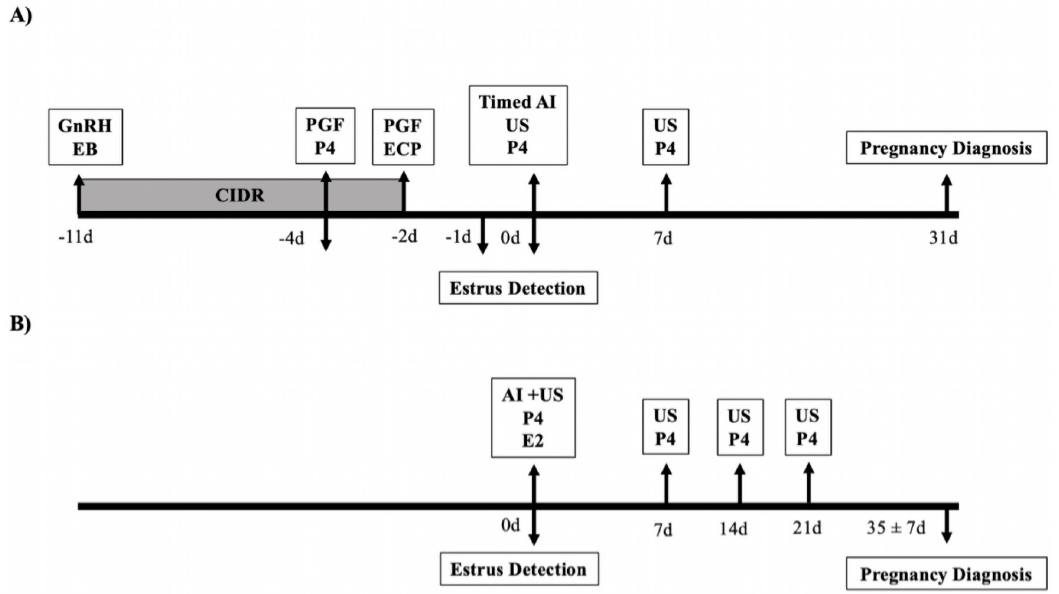
Fig 1. Schematic of the experimental design for Experiment 1 (Exp.1; panel A) and Experiment 2 (Exp.2; panel B). EB (estradiol benzoate; 2 mg, Gonadial, Zoetis, S ã o Paulo, Brazil), GnRH (gonadorelin diacetate; 100 μ g, Cystorelin, Merial, S ã o Paulo, Brazil), CIDR (intravaginal progesterone implant; 1.9 g progesterone; CIDR, Zoetis, S ã o Paulo, Brazil), PGF (dinoprost tromethamine; 25 mg, Lutalyse, Zoetis, S ã o Paulo, Brazil), ECP (estradiol cypionate; 1mg, E.C.P., Zoetis, S ã o Paulo, Brazil), Timed AI (artificial insemination), AI (artificial insemination, followed by spontaneous estrus using the am/pm rule; Exp. 2 only), US (examination of ovaries with ultrasonography), P4 (collection of blood sample for analysis of progesterone concentration), E2 (collection of blood sample for analysis of estradiol concentrations). Automated detection of estrus was done using a leg-mounted pedometer in Exp. 1 (Afimilk Pedometer Plus Tags; Afimilk, Kibbutz Afikim, Israel) and a neck-mounted accelerometer in Exp. 2 (Heatime 1 , SCR Engineers,